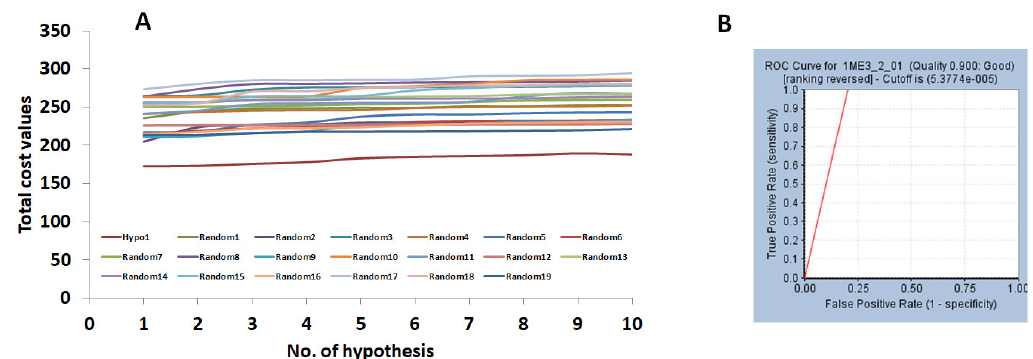
Figure 4. Validation of the pharmacophore models. ( A ) Evaluates the difference in cost between 19 scrambled runs selecting 95% confidence level. Pharm 1 had displayed a lower cost value. ( B ) Depicts the ROC curve of pharm 2 projecting the model to be of good quality. Table 3. Different values computed by pharm 1 and pharm 2 employing decoy set method.